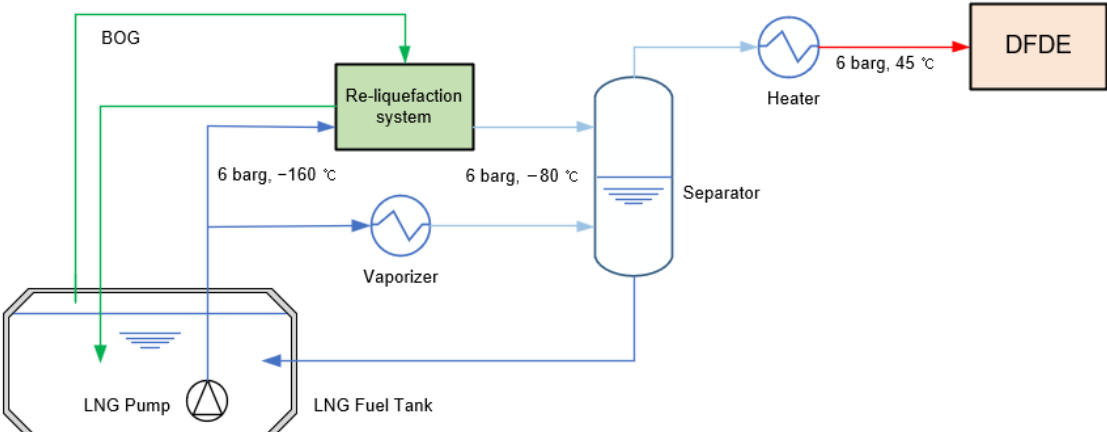
Figure 3. Proposed LNG fuel gas supply system for the DFDE Engine.